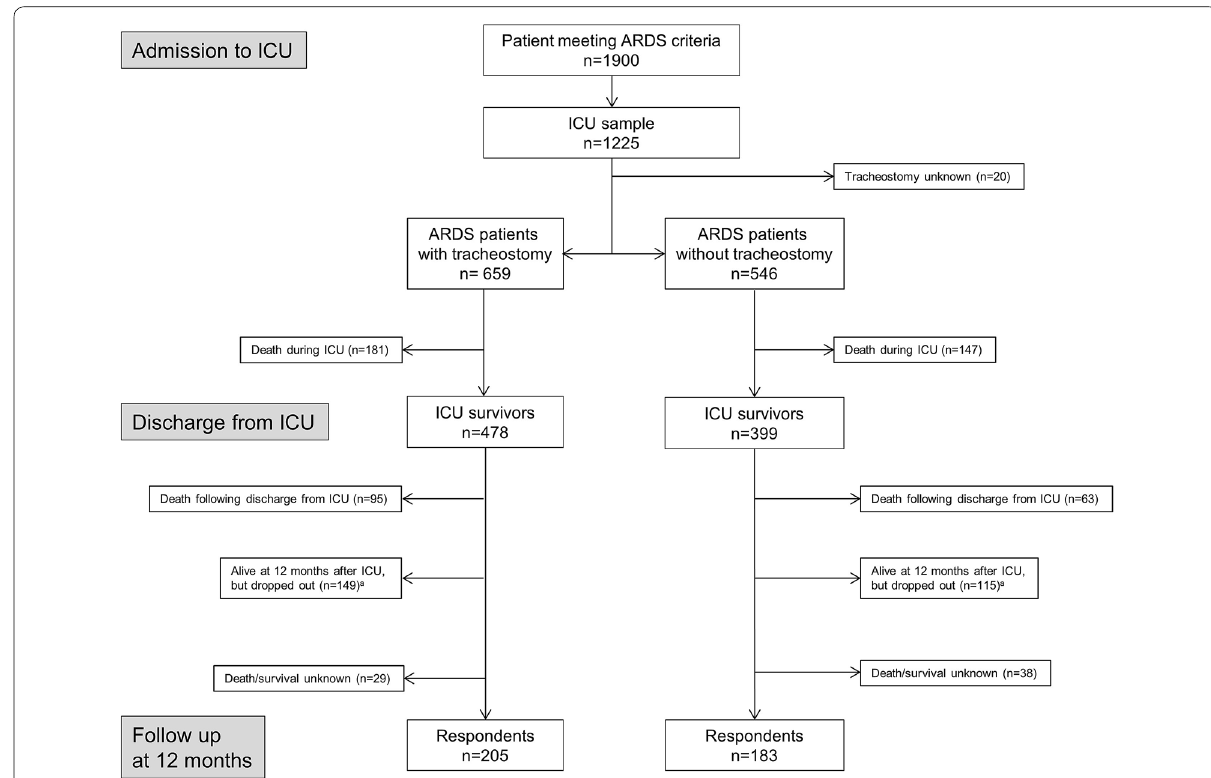
Fig. 1 Consort statement—flow chart of ARDS patients throughout the study ( a reasons for drop‑out for all patients: unable to participate in the study or to understand German, declined participation; incorrect address or new address unknown, organisational failure; survival was assessed by means of local municipal population